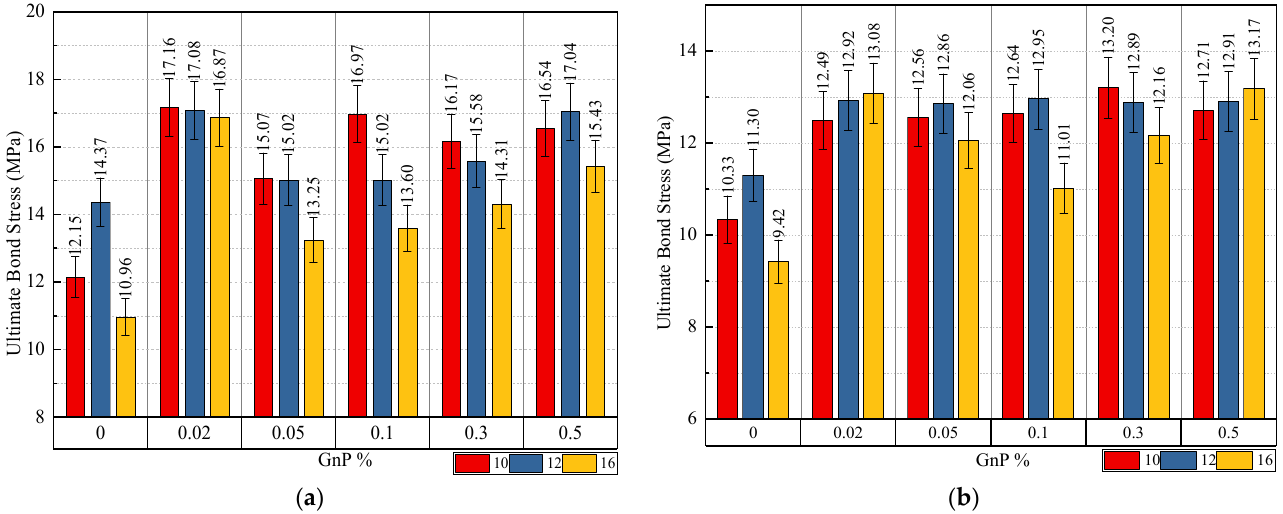
Figure 11. Impact of the diameter of the steel bar on ultimate bond stress for specimens with embedded length: ( a ) 9 d b ; ( b ) 12 d b .